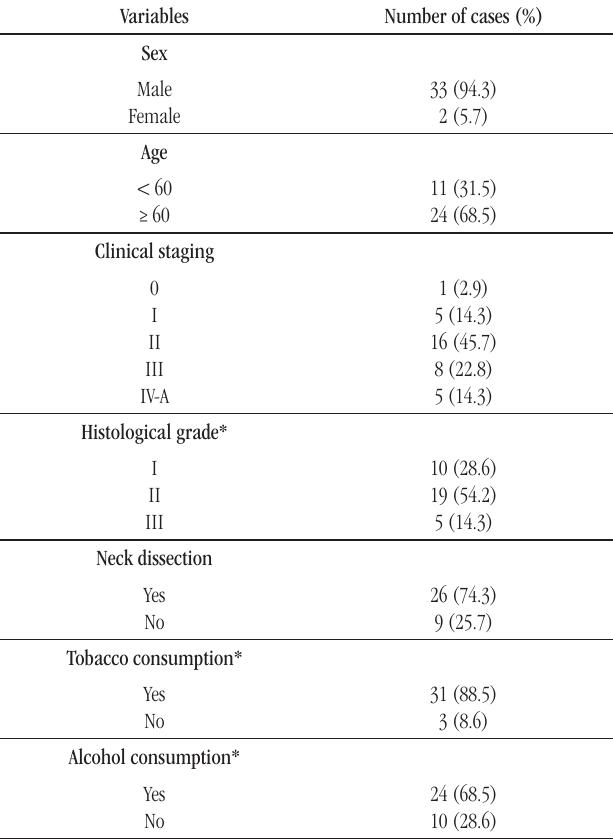
taBLE 2 − General characteristics in 35 patients with floor of mouth SCC